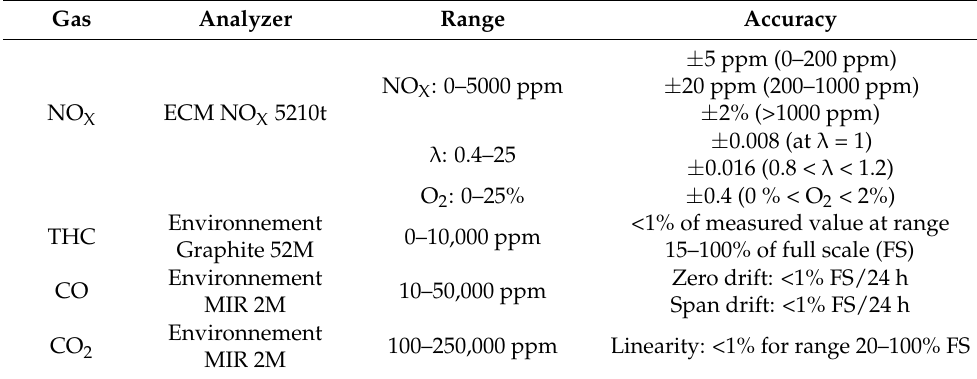
Table 4. Specification of exhaust gas analyzers and